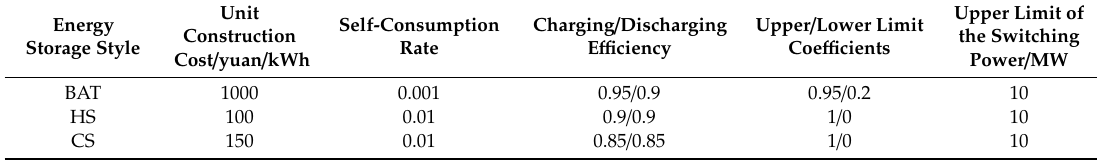
Table 3. Parameters of energy storage.